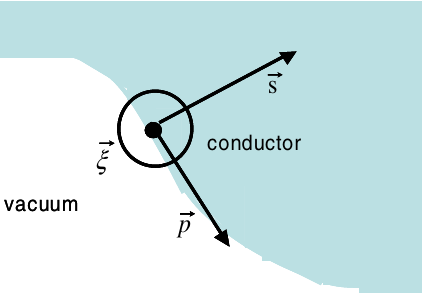
FIG. 5. Boundary local coordinate